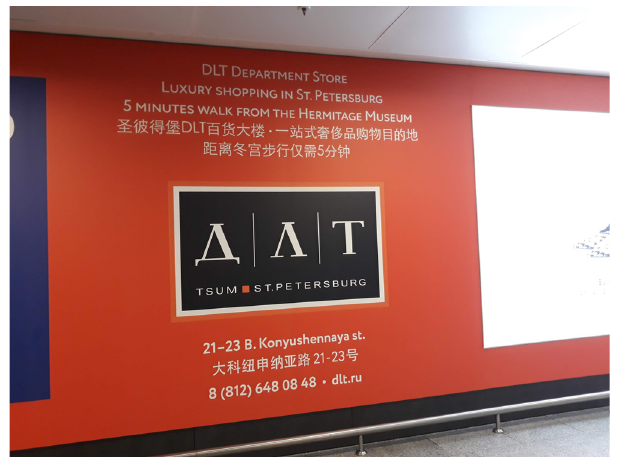
Figure 8: Advertisement for TSUM, Pulkovo airport, St. Petersburg, 2018, LinguaSnapp